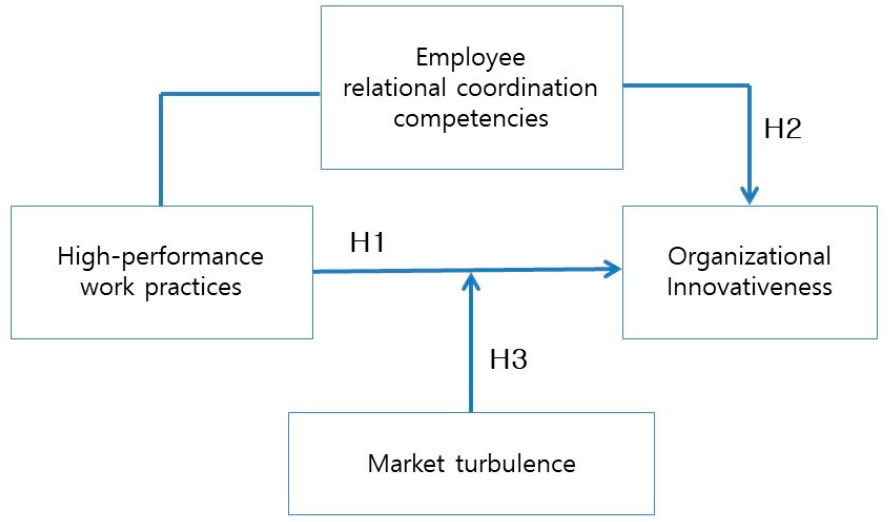
Figure 1. Research Figure 1. Research Model .